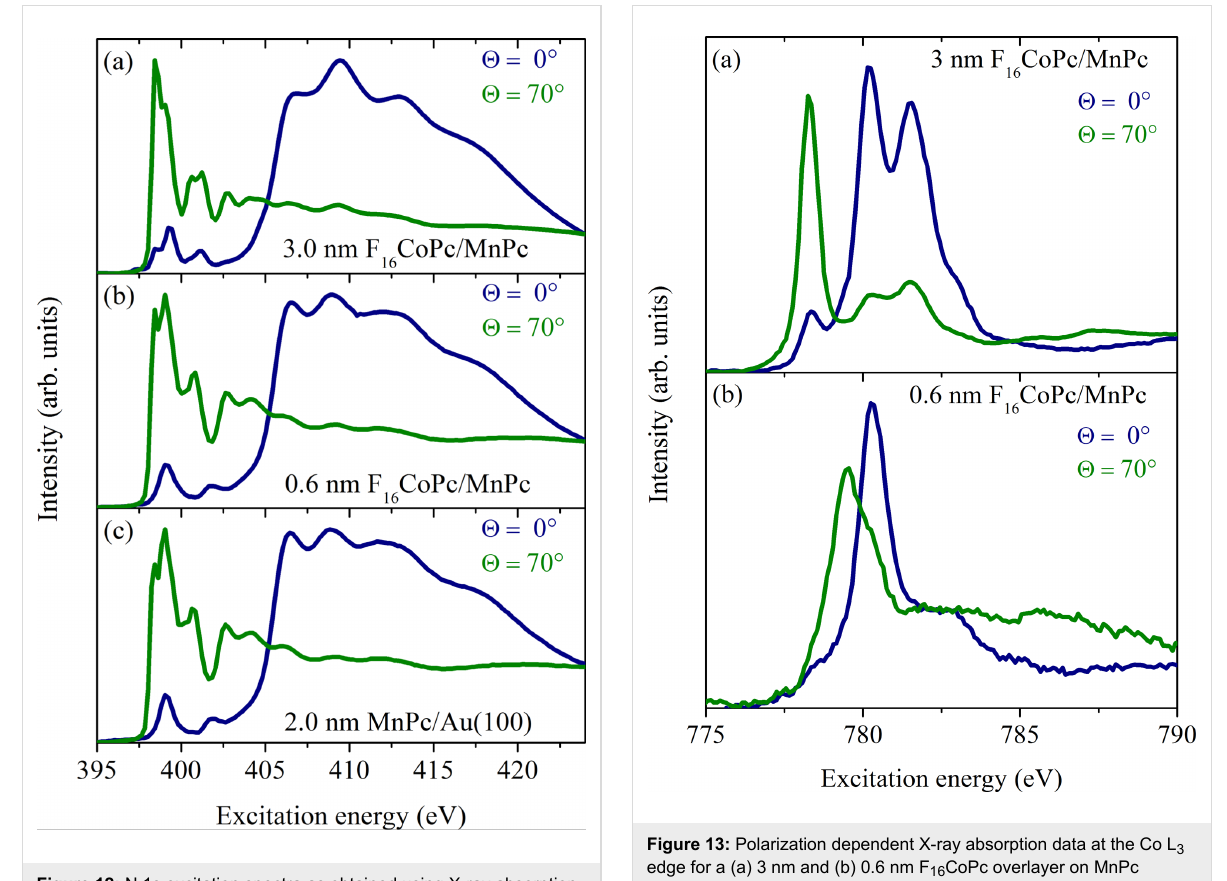
Figure 12: N 1s excitation spectra as obtained using X-ray absorption spectroscopy (adapted from [127]). Corresponding data for (c) a 2.0 nm thick MnPc film on Au(100), (b) an additional 0.6 nm thick F 16 CoPc overlayer on MnPc, and (a) a relatively thick F 16 CoPc over- layer (3 nm) are depicted. The spectra were recorded with two differ-